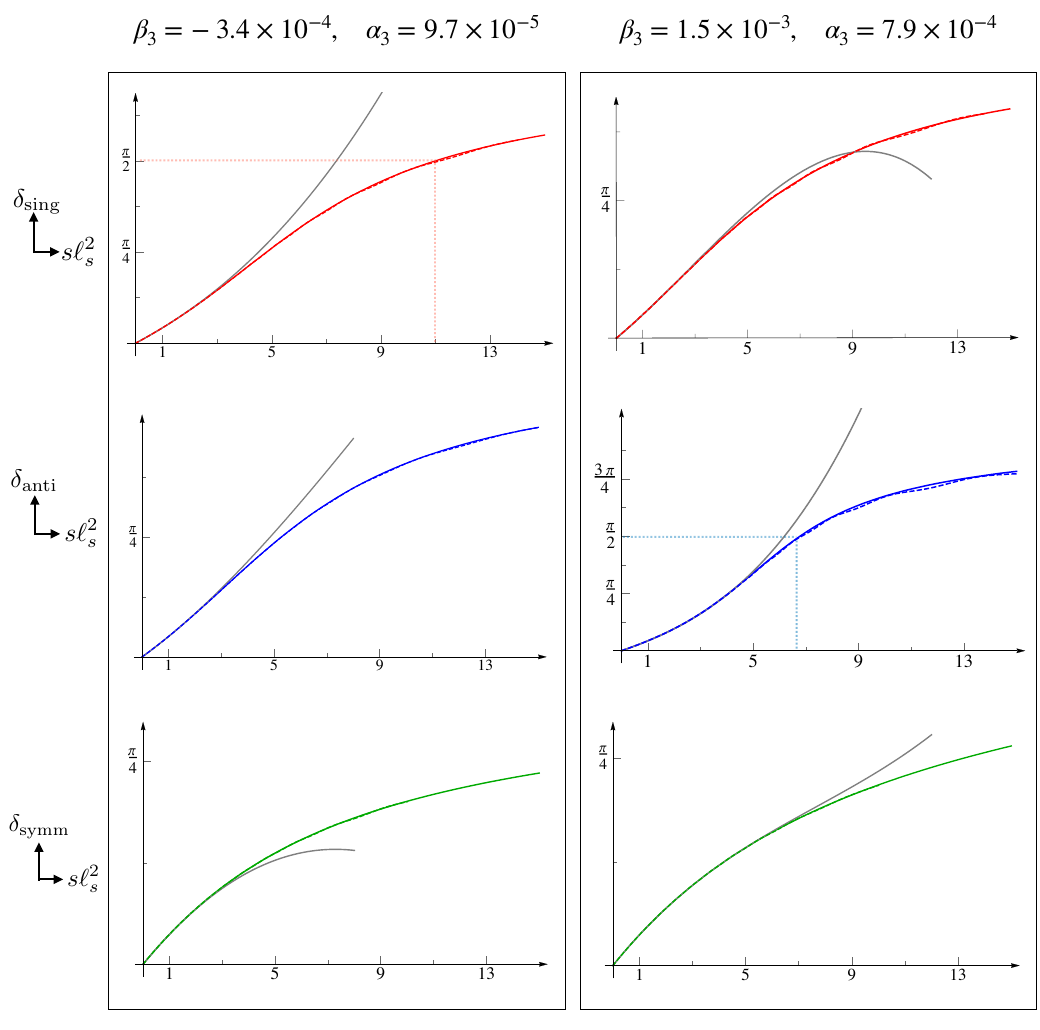
Figure 3 . Phase shifts δ I = 1 log S I as a function of s‘ 2 for some irrep I , with I ={singlet, s 2 i antisymmetric, symmetric} respectively in red, blue and green. In each plot, solid line is obtained from primal numerics with N max = 120 , the dashed line is obtained from the dual with N ∗ = 30 . The gray lines are the predictions from the EFT up to two-loops. The left panel shows the phase shifts for an arbitrary β 3 < 0 : in the singlet channel there is a sharp resonance, signaled by the phase shifts passing through π/ 2 . The right panel shows the phase shifts for a fixed β 3 > 0 : in this case we see an axion resonance in the antisymmetric channel. Notice that for both points the EFT prediction agrees well with the non perturbative completion up to the scale set the by the lightest resonance, which, for this values of β 3 we chose appears dynamically around the naive cutoff scale s ∗ = 4 /‘ 2 s